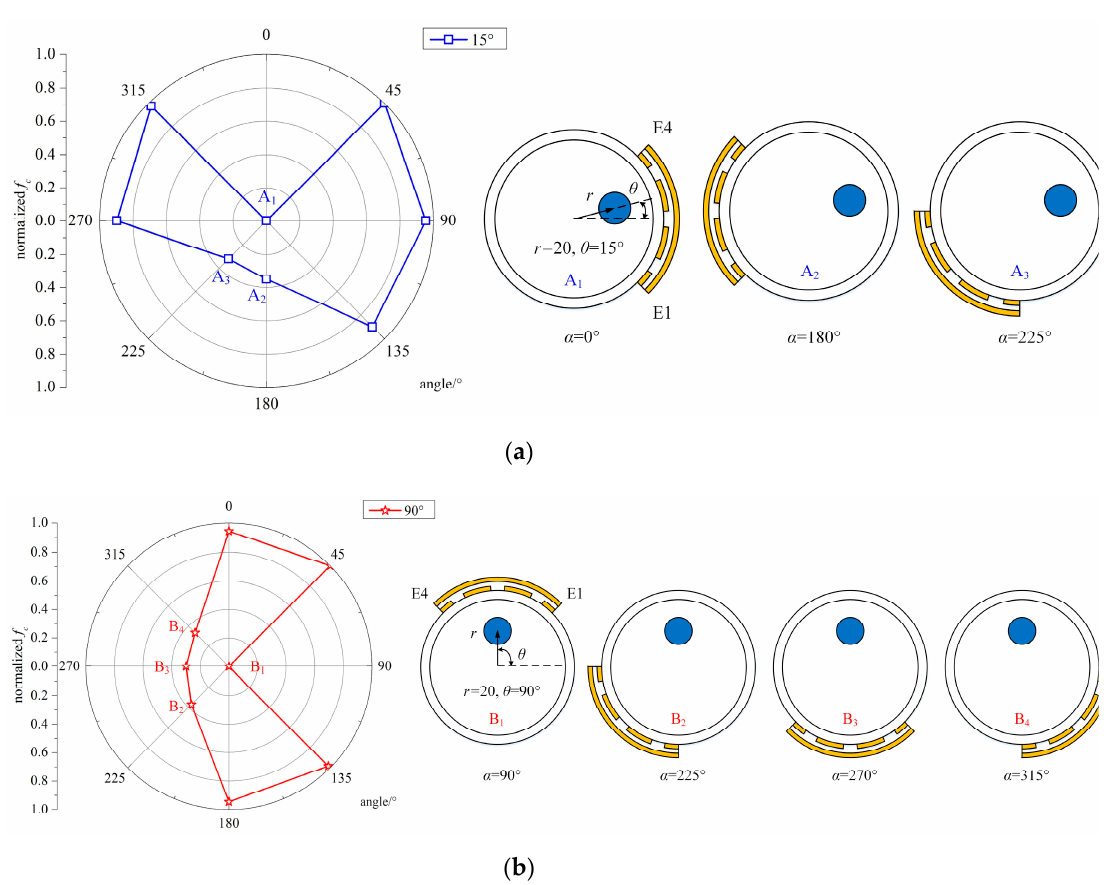
Figure 10. The normalized simulated capacitance between E1 and E4 and the special positions for θ detection. ( a ) θ = 15°, r = 20 mm, α = 0°, 180°, 225°; ( b ) θ = 90°, r = 20 mm, α = 90°, 225°, 270°, 315 °.